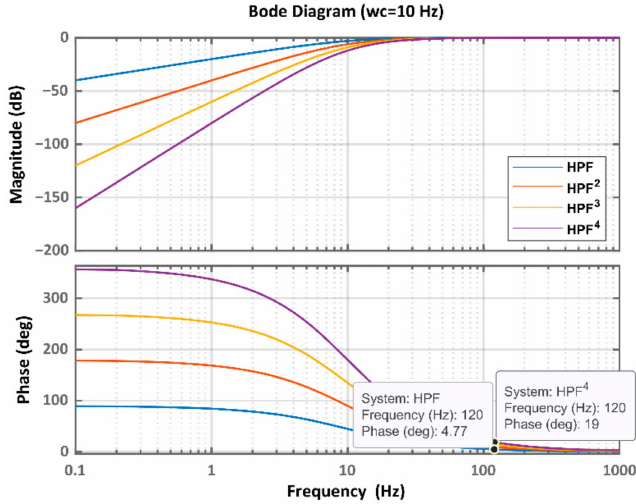
Figure 9. Frequency analysis for conventional HPFs.